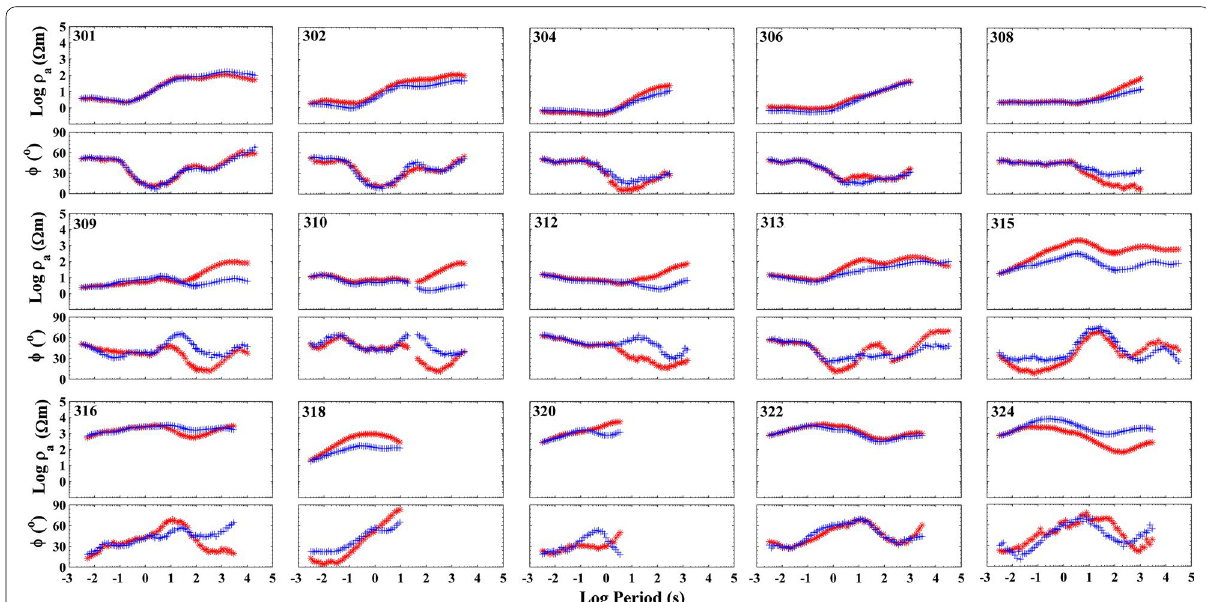
Fig. 4 Apparent resistivity and phase curves for representative stations of data used in 2D inversion. Blue color color * represents TE mode